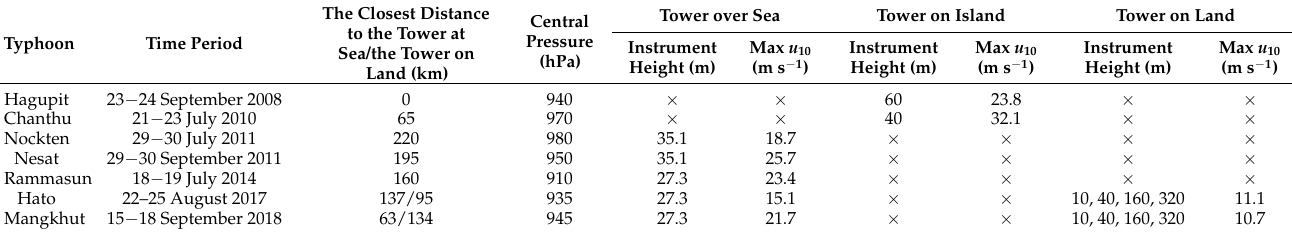
Table 1. Information of the data during the seven typhoon events.